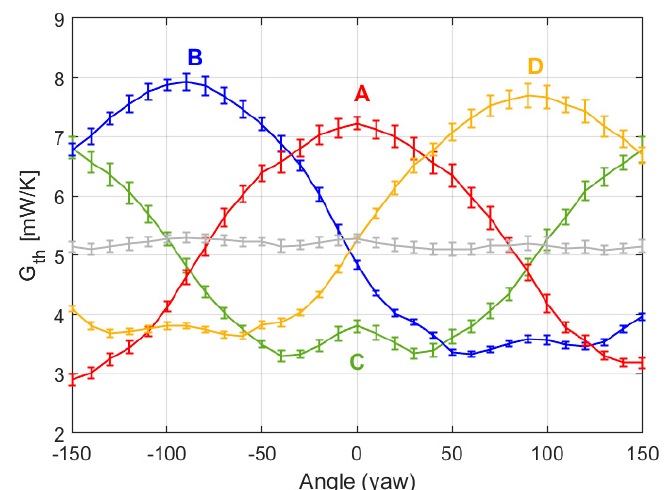
Figure 27. Experimental results showing the evolution with the yaw angle of the average convective heat transfer coefficient G th of each sector of the sphere (inferred from the average power delivered to each sector) at Re = 2000. The grey line is the average G th of the sectors. The 1 σ error bars of the measurements are also shown. The disposition of the sectors A, B, C and D is the same the one shown